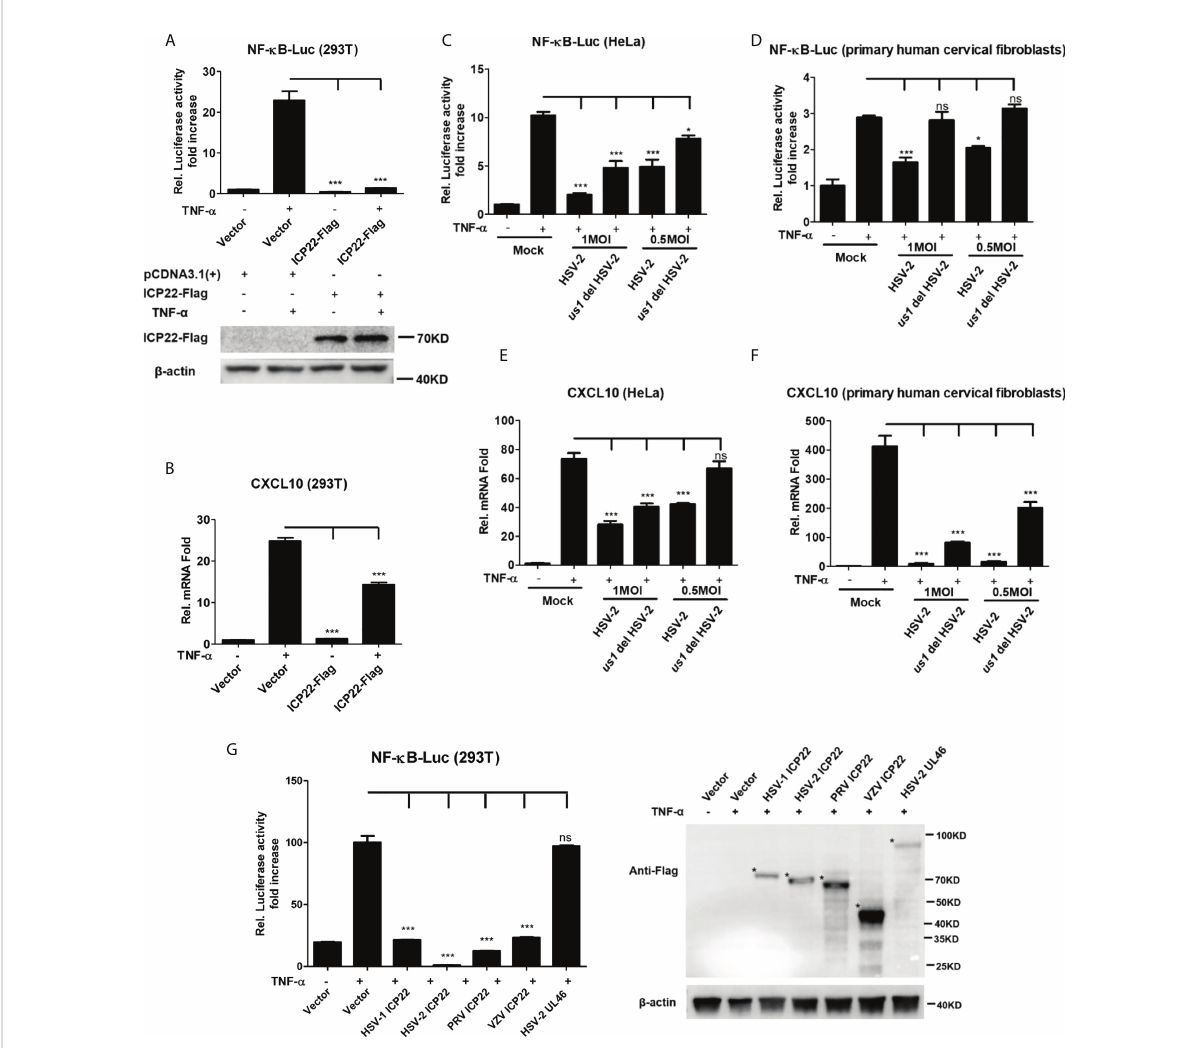
FIGURE 2 HSV-2 ICP22 inhibits TNF- a -induced NF- k B activation. (A) HSV-2 ICP22 suppresses TNF- a -induced NF- k B activation. HEK 293T cells were seeded in 24-well plates overnight and co-transfected with the reporter plasmids pNF- k B-Luc and phRL-TK together with ICP22-expressing plasmid. At 24 h post-transfection, cells were stimulated with TNF- a (20 ng/ml) for 6 h. Reporter activities were determined by DLR assay. The expression of ICP22 was detected by western blot using the anti-Flag Ab. (B) HSV-2 ICP22 suppresses the production of CXCL10 mRNA. HEK 293T cells seeded in 6-well plates were transfected with vector or ICP22-expressing plasmid. At 24 h post-transfection, cells were stimulated with TNF- a (20 ng/ml) for 6 h. Cells were harvested and total RNA was extracted. The expression of CXCL10 and GAPDH genes was evaluated by relative real-time quantitative PCR. (C, D) . ICP22 knockout impairs the inhibitory activity of HSV-2 on NF- k B activation. HeLa cells or primary human cervical fi broblasts were seeded in 24-well plates overnight and transfected with the reporter plasmids pNF- k B-Luc and phRL-TK, followed by infection with HSV-2 or us1 del HSV-2. After stimulation with TNF- a for 6 h, reporter activities were determined by DLR assay. (E, F) . HSV-2 ICP22 knockout impairs the inhibitory activity of HSV-2 on CXCL10 mRNA production. HeLa cells or primary human cervical fi broblasts seeded in 6-well plates were infected with HSV-2 or us1 del HSV-2 at an MOI of 1. After stimulation with TNF- a for 6 h, cells were harvested and total RNA was extracted. The expression of CXCL10 and GAPDH genes was evaluated by relative real-time quantitative